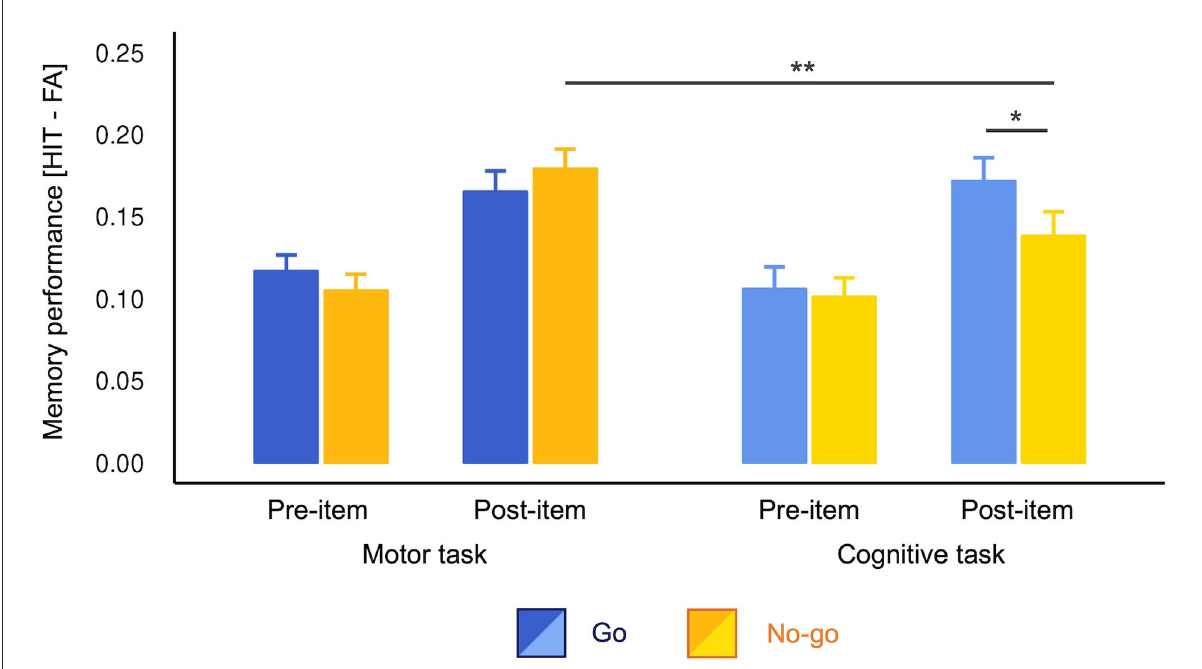
FIGURE2 Memory performance across conditions. Performance was calculated by subtracting the false alarm rates from the hit rates. The No-go post-items were better memorized in the motor task than in the cognitive task. The Go post-items were better memorized than No-go post-items in the cognitive task only in the motor cognitive task. The error bars depict standard errors of measurement. * p < 0.05, ** p <